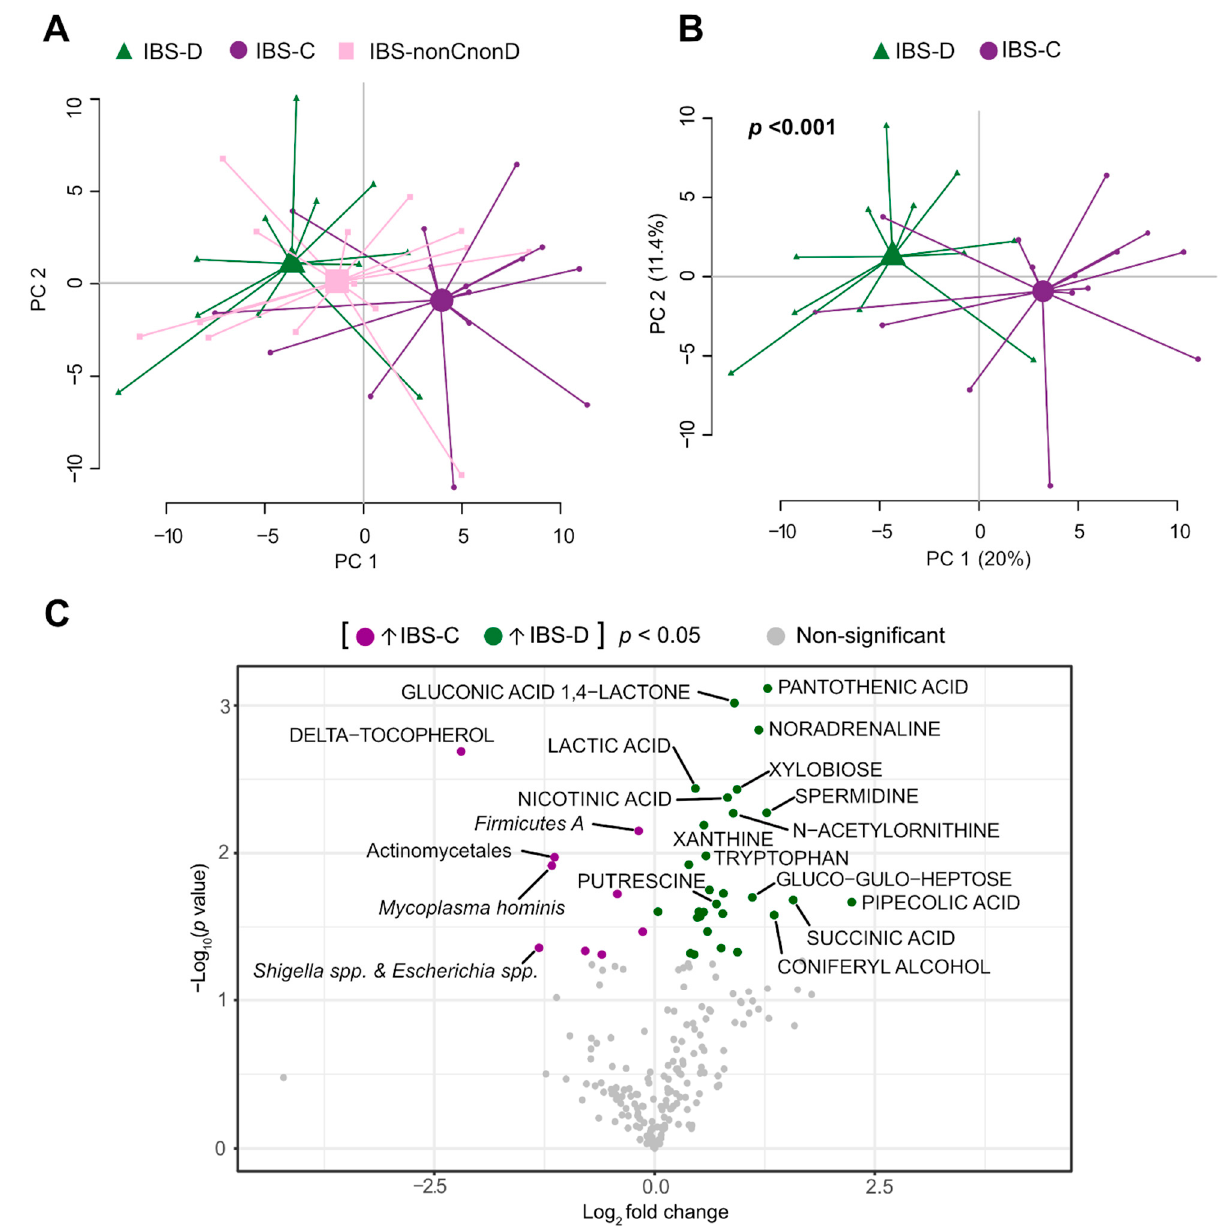
Figure 2. Faecal microbiota and metabolite profiles of IBS patients based on the predominant bowel habit. Principal component analysis (PCA) score scatter plot based on faecal bacteria and metabolites showing ( A ) IBS-D ( n = 11, green triangles), IBS-C ( n = 15, purple circles) and IBS-nonCnonD ( n = 14, pink squares) patients and ( B ) patients with the predominant bowel habit, IBS-D and IBS-C. The p value depicts the statistical significance of the distance between the centroids (scores averages) of the groups. ( C ) Volcano plot illustrating statistical significance versus mean fold change of 54 bacteria (probe intensity) and 155 metabolites (signal intensity) between IBS-D patients respect to IBS-C patients (IBS-D/IBS-C). Each dot corresponds to a bacteria probe or metabolite signal. Variables increased in IBS-D are coloured in green ( n = 29), while decreased variables compared to IBS-C are coloured in purple ( n = 9). Mean fold change is shown as log 2 . p values are shown as –log 10 ; p values < 0.05 are coloured; non-significant p values are shown in grey. Student’s t -test was used to identify differences between the groups. Not all variables were labelled, only some bacteria and metabolites with log 2 (IBS/H) < − 1 and >+1 and p values < 0.05.